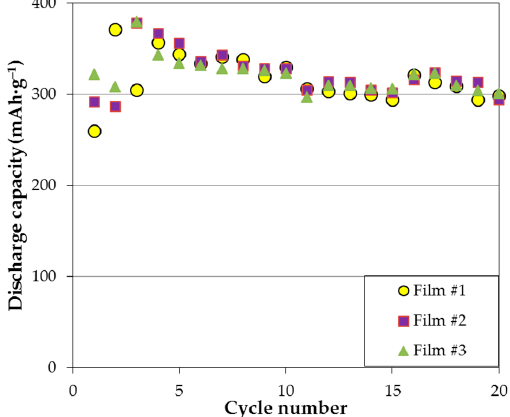
Figure 3. Cycling performances of Mg-Ni-Co thin film: #1 (Mg 41.9 Ni 50.9 Co 7.2 deposited on liquid nitrogen-cooled nickel substrate); #2 (Mg 44.8 Ni 46.8 Co 8.4 deposited on liquid nitrogen-cooled nickel substrate); and #3 (Mg 37.7 Ni 54.6 Co 7.7 deposited on ice water-cooled nickel substrate) with 100 mA·g − 1 charge and discharge current densities. All films show similar cycling behavior. Two or three cycles are needed for activation, and once the electrodes are fully activated, steady capacity degradation is observed until around cycle 10. Capacity maintains stability from cycle 10 to 20.